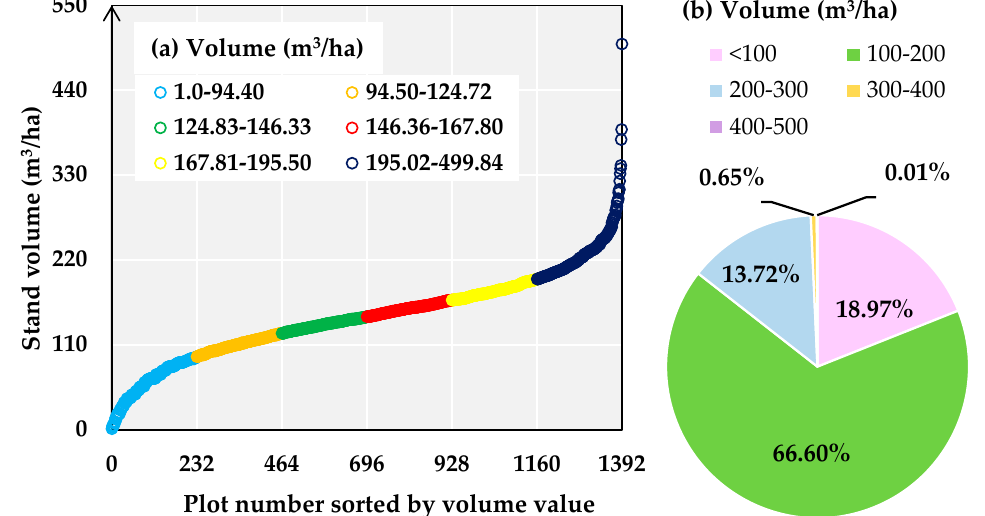
Figure 2. The values of measured stand volume. ( a ) Field sample profiles of volume in the study site from Plot 1 to 1,392; ( b ) Components of volume.